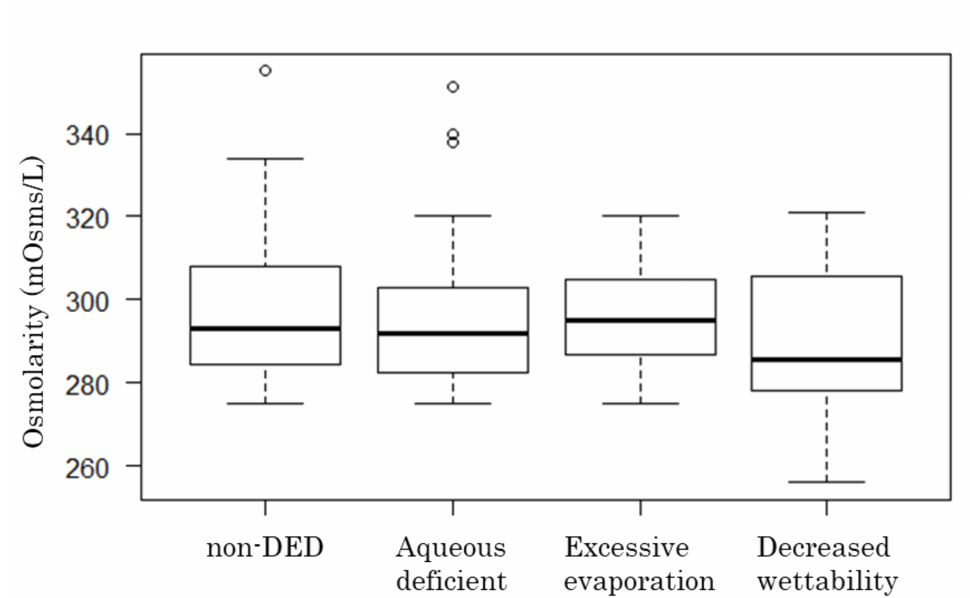
Figure 4. Comparison of osmolarity values among tear breakup pattern (TBUP) subgroups. There was no significant di ff erence in osmolarity among the groups ( p > 0.05, Tukey–Kramer test). Bold line denotes median, and upper and lower ends of the box denote 75th and 25th percentile, respectively. Upper and lower error bars denote maximum and minimum values,